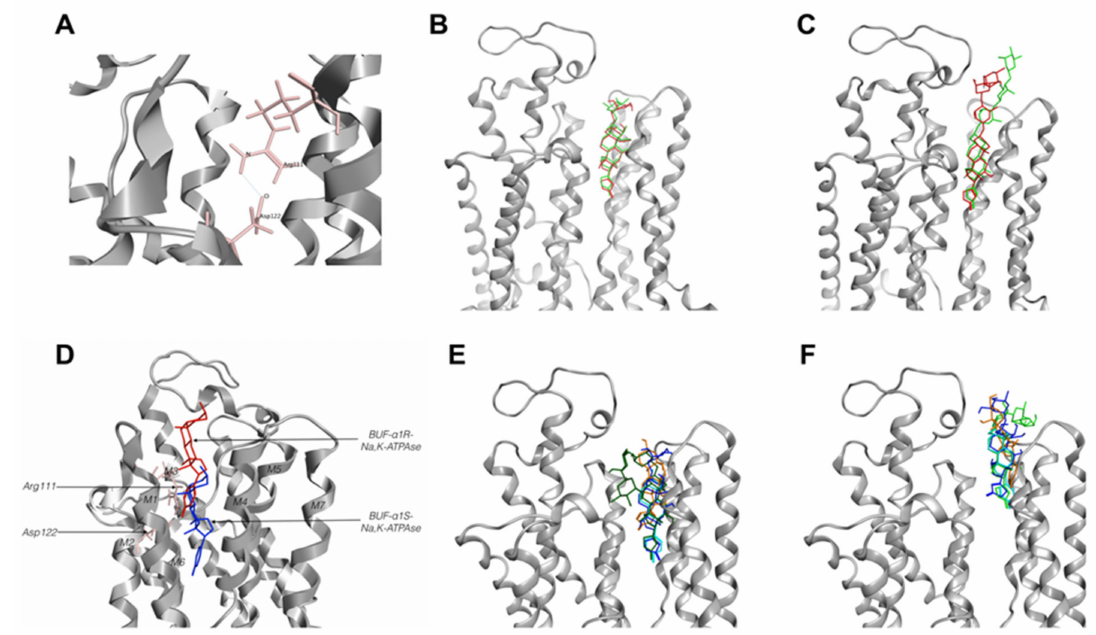
Figure 3. Cardiotonic steroids-binding site in Na,K-ATPase models. ( A )—cardiotonic steroids (CTSs) binding site in α 1R-Na,K-ATPase. Hydrogen bonds between Arg111 and Asp122 in α 1R-Na,K-ATPase. ( B , C )—verification of ouabain and digoxin position in CTSs-binding site of α 1S-Na,K-ATPase. Comparison from X-ray 4HYT and 4RET structures with docking models: ( B )—ouabain in 4HYT structure, ( C )—digoxin in 4RET structure. CTSs from 4HYT or 4RET colored red, CTSs from docking models colored green. ( D )—bufalin position in CTSs-binding site of α 1S- (blue) and α 1R-Na,K- ATPase (red). Models based on the 4HYT structure of Na,K-ATPase. ( E , F )—CTSs positions in the CTSs-binding site of α 1S-Na,K-ATPase ( E ) and α 1R-Na,K-ATPase ( F ) for CTS. Bufalin—shown in turquoise, digoxin—green, ouabain—blue, marinobufagenin—orange. Models based on the 4HYT structure of Na,K-ATPase.